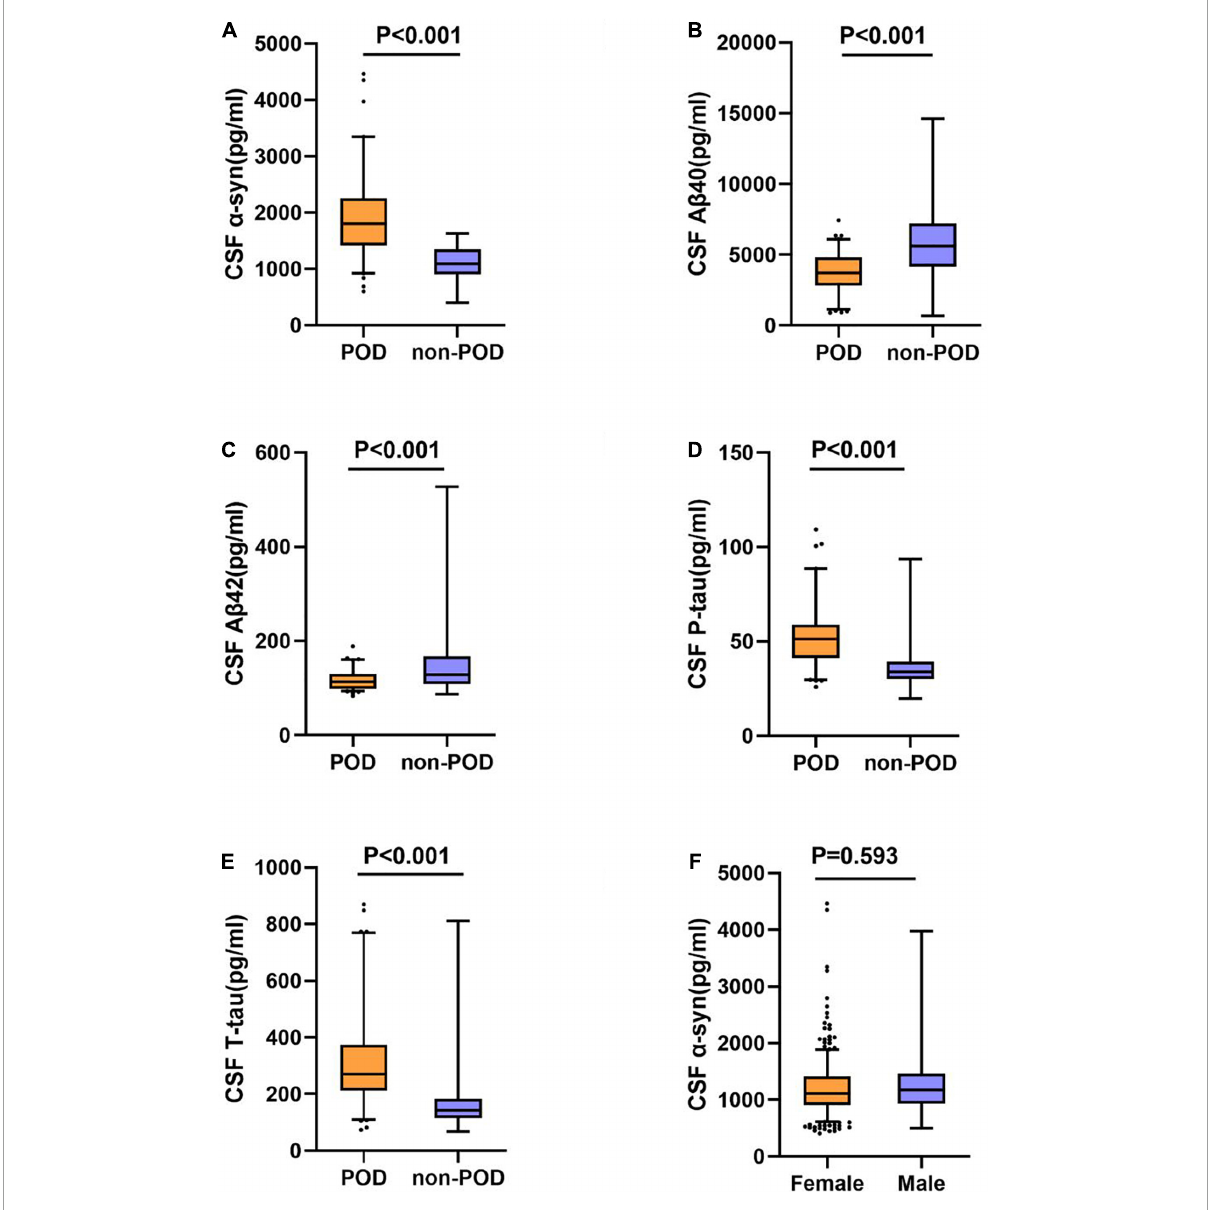
FIGURE2 Expression of α -syn and biomarkers in CSF of POD patients and non-POD controls. The scatter plots showed the expression levels of α -syn (A) , A β 40 (B) , A β 42 (C) , P-tau (D) , and T-tau (E) . CSF α -syn levels are independent of gender (F) . The colors of scatter maps are grouped according to different diagnostic groups. The P -value was determined by Mann-Whitney U -test. The contents of CSF biomarkers in patients with POD (POD group) were significantly different than those in patients without POD (non-POD group) ( P < 0.001). POD, postoperative delirium; CSF, cerebrospinal